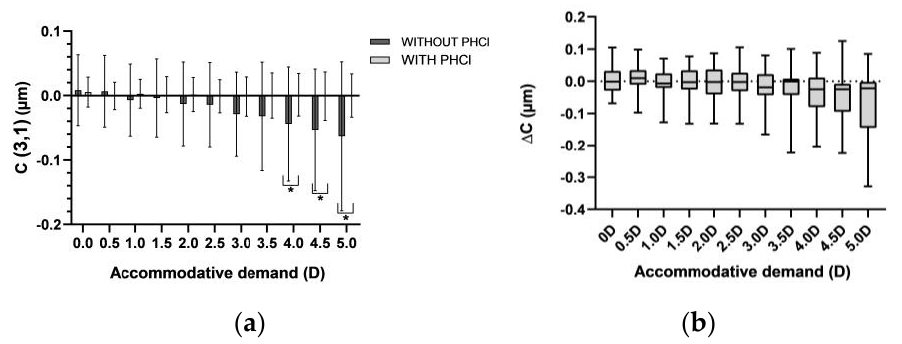
Figure 4. ( a ) Horizontal coma Zernike coefficients for the different target accommodations, with and without PHCl (grey and black bars, respectively). ( b ) Box plot of the difference in Zernike coefficients between natural conditions and after instillation of PHCl for each accommodative demand. * Denote statistically significant values ( p < 0.05). Error bars represent the standard deviation (SD).